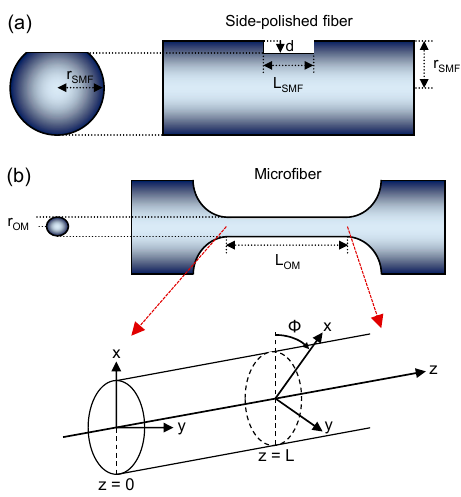
Figure 10. Side view of ( a ) a side-polished fiber, and ( b ) the waist of a tapered fiber. Expanded: Schematic diagram of the spun microfiber with a constant spin rate φ along fiber axis z . Typically r SMF = 62.5 µ m, r OM is between 1 µ m and 10 µ m, L is between 0.1 µ m and 1 m, and φ is between 0 and 100 π /cm.